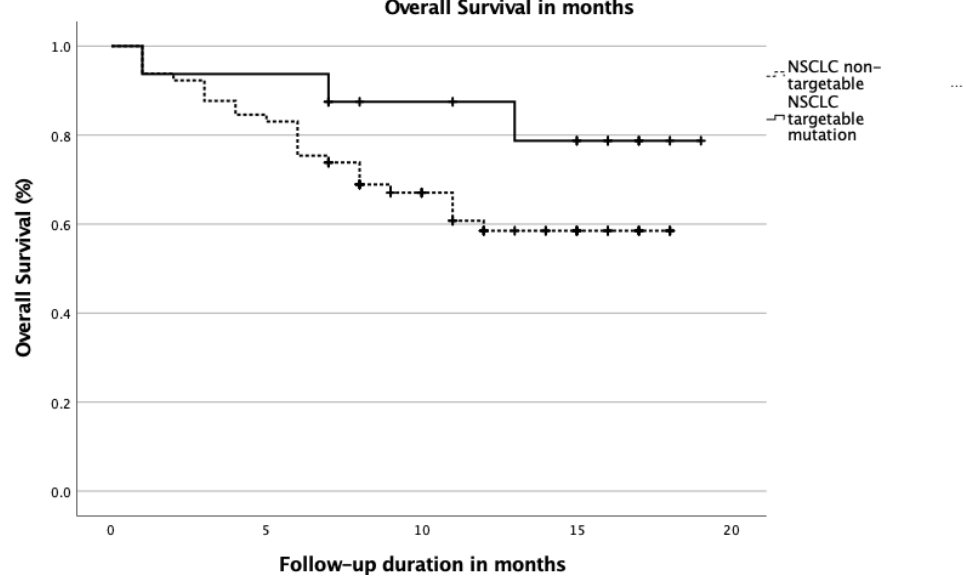
Figure 1. Kaplan – Meier survival curve stratified for NSCLC patients with and without a targetable driver mutation. Abbreviations; NSCLC; non-small cell lung cancer.